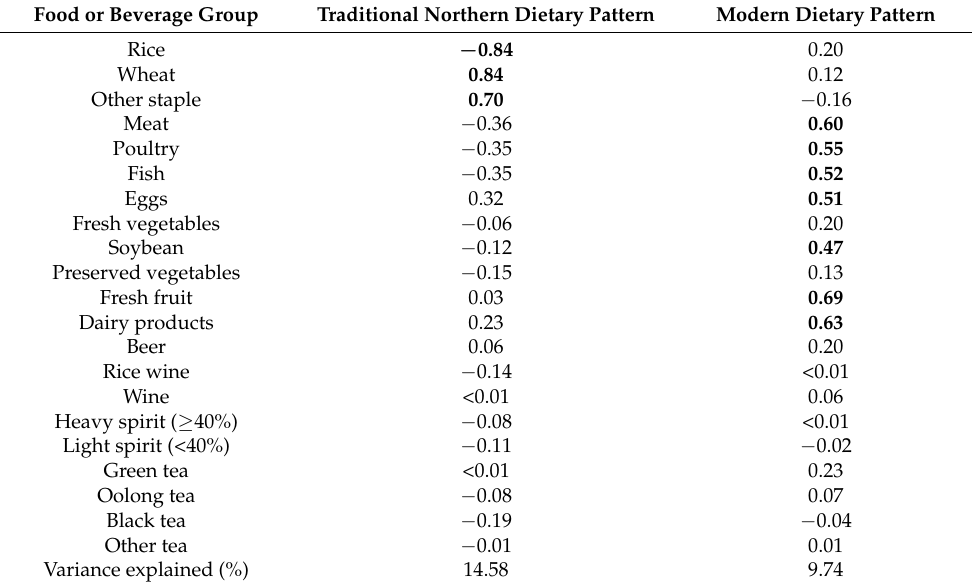
Table 1. Factor loading matrix of major dietary patterns by principal component analysis with varimax rotation ( n = 481,424).